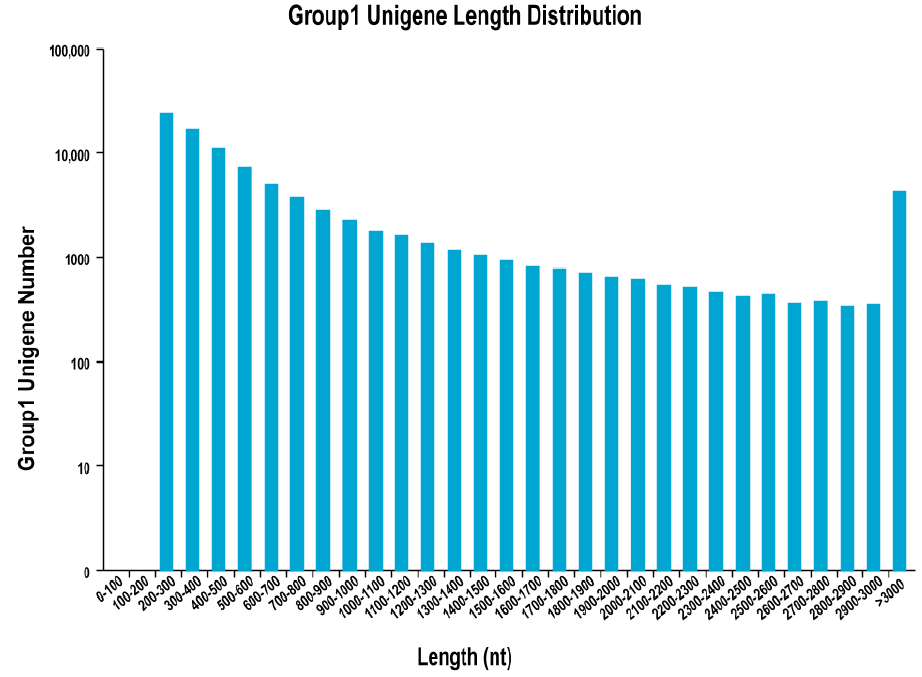
Figure 2. Unigene length distribution. The abscissa indicates the length of the unigene, and the ordinate indicates the number of unigene of a certain length.